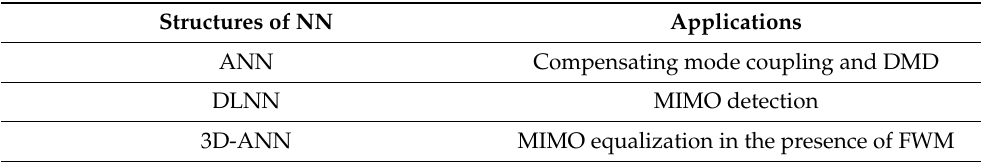
Table 4. Applications of neural network in MIMO